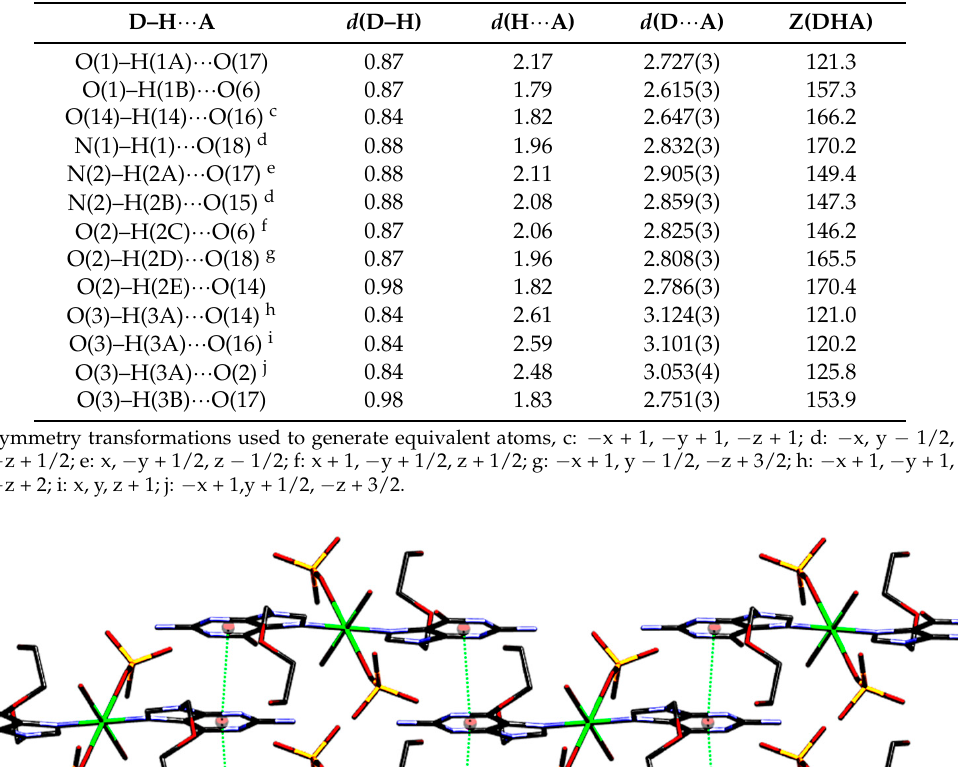
Table A3. Hydrogen bonds for compound 1 (Å, ◦ ).